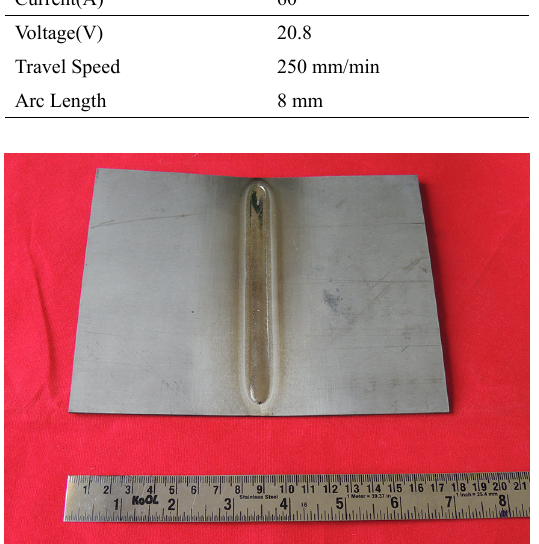
Figure 1. Deformation of thin sheets after